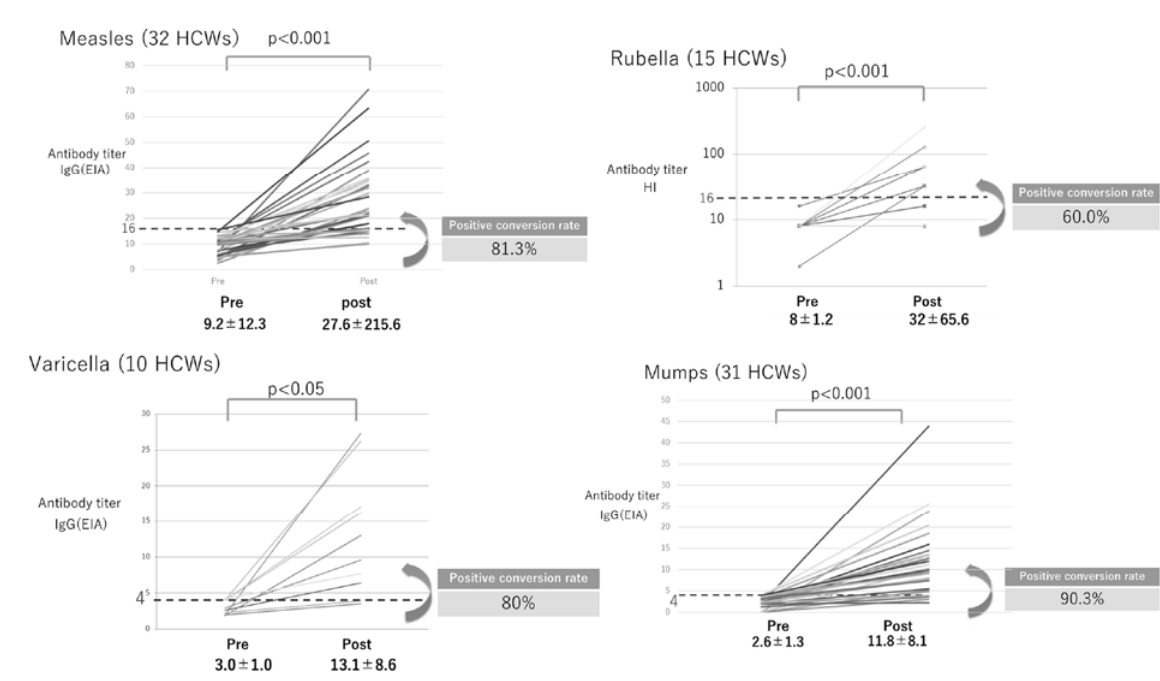
Figure 2: Change of antibody titers against measles, rubella, mumps, and varicella before and after single dose vaccine inoculation is shown. All of the four types of vaccines achieved an increase of antibody titer after a single inoculation. EIA: enzyme immunoassay; HCWs: health care workers; HI: hemagglutination inhibition